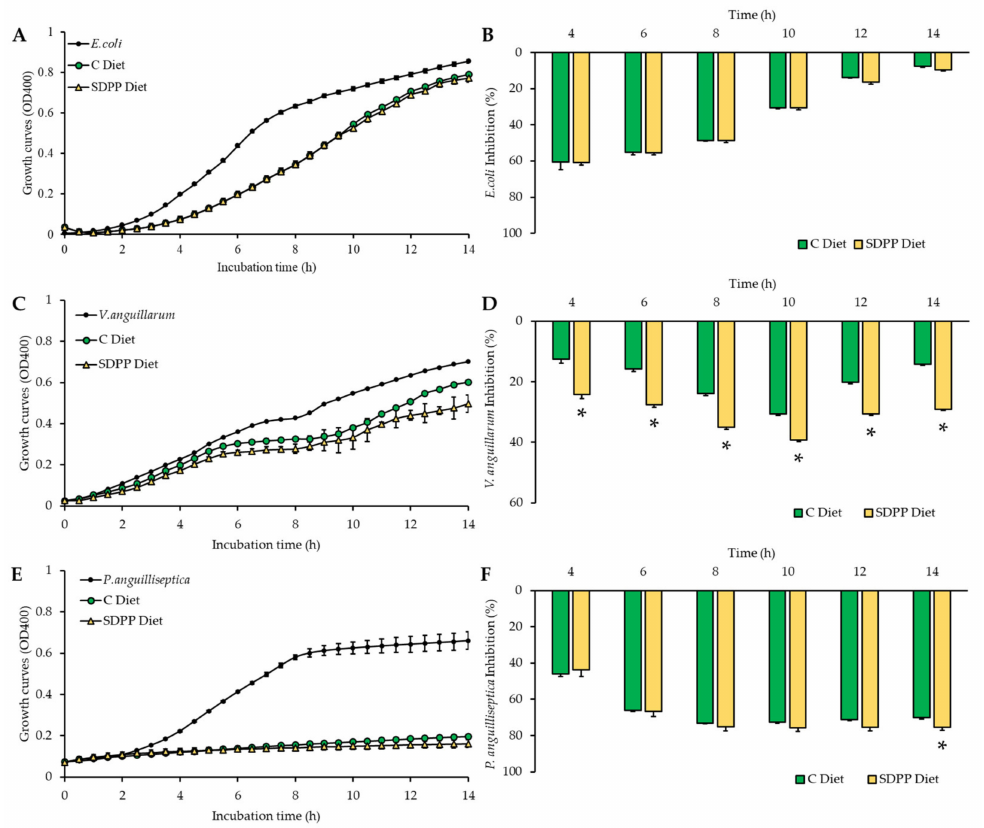
Figure 1. Skin mucus bacterial growth and inhibition rate. The bacterial growth ( left ) and the bacterial inhibition rate ( right ) are shown for ( A , B ) E. coli , ( C , D ) V. anguillarum , and ( E , F ) P. anguilliseptica co-cultured for 14 h with gilthead seabream ( Sparus aurata ) skin mucus from fish fed with the control diet (C Diet) and SDPP Diet. Data are shown as mean ± standard error of the mean ( n = 9). An asterisk (*) indicates statistically significant differences between diets at measured times of co-culture ( t -test; p <